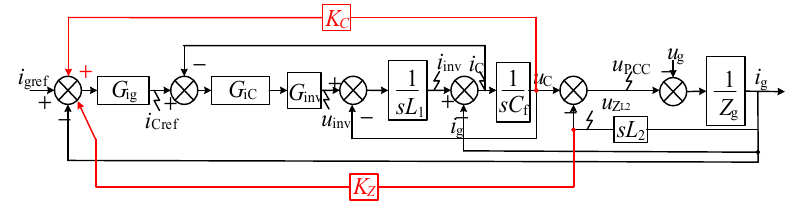
Figure 10. The structure of capacitor voltage and grid-side inductor voltage feedback control loop.